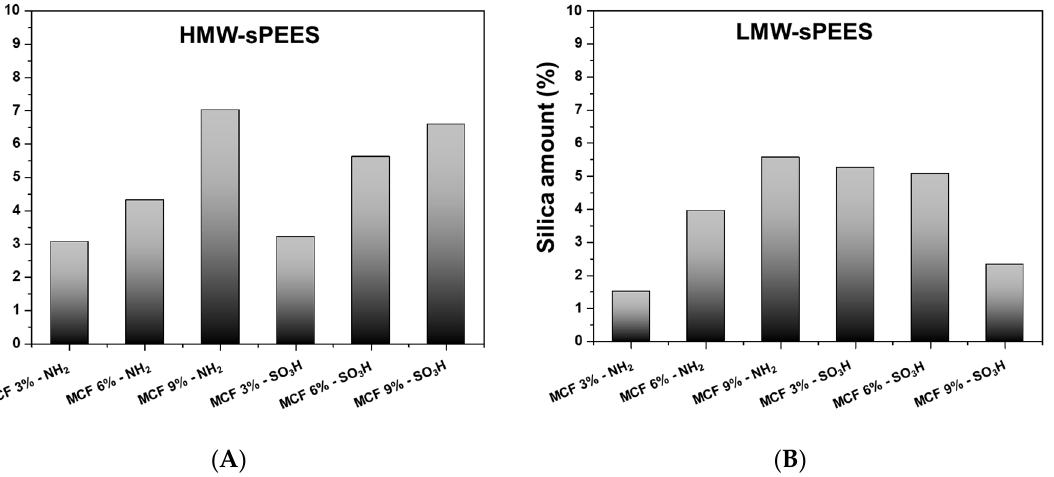
Figure 11. Final silica content MCF-NH 2 and MCF-SO 3 H in the membranes of ( A ) HMW-sPEES and ( B ) LMW-sPEES. ( B )